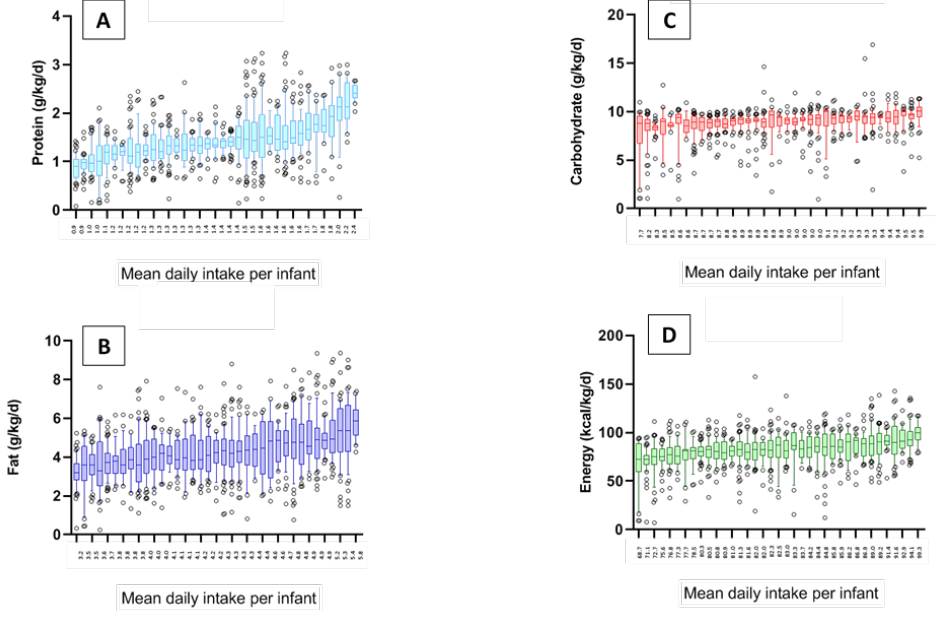
Figure 2. Boxplots showing variation in intakes of protein (panel A ), fat (panel B ), carbohydrate (panel C ), and energy (panel D ) from unfortified milk. Each boxplot represents one participant ( n = 37). Day-to-day intakes varied for all participants. Boxplots were ordered by mean daily intake along the x-axis. When taken together, these plots illustrate substantial between-infant variation in average intakes over the NICU hospitalization (range in mean protein intake, 0.9 to 2.4 g/kg per day; fat 3.2 to 5.8 g/kg per day; carbohydrate 7.7 to 9.9 g/kg per day; energy 69 to 99 kcal/kg per day).